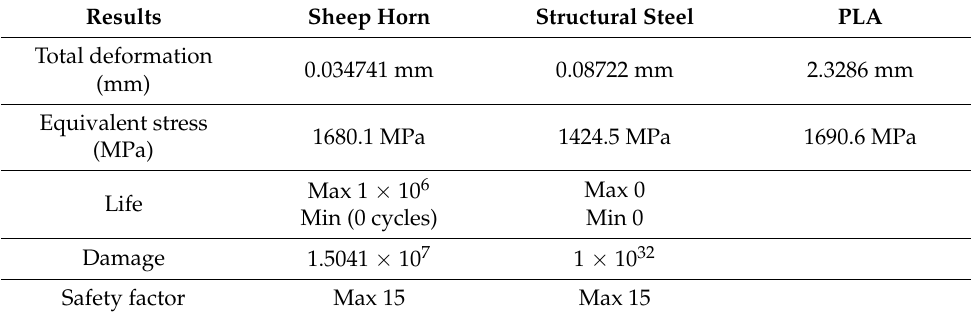
Table 8. Simulation study comparison for walnut